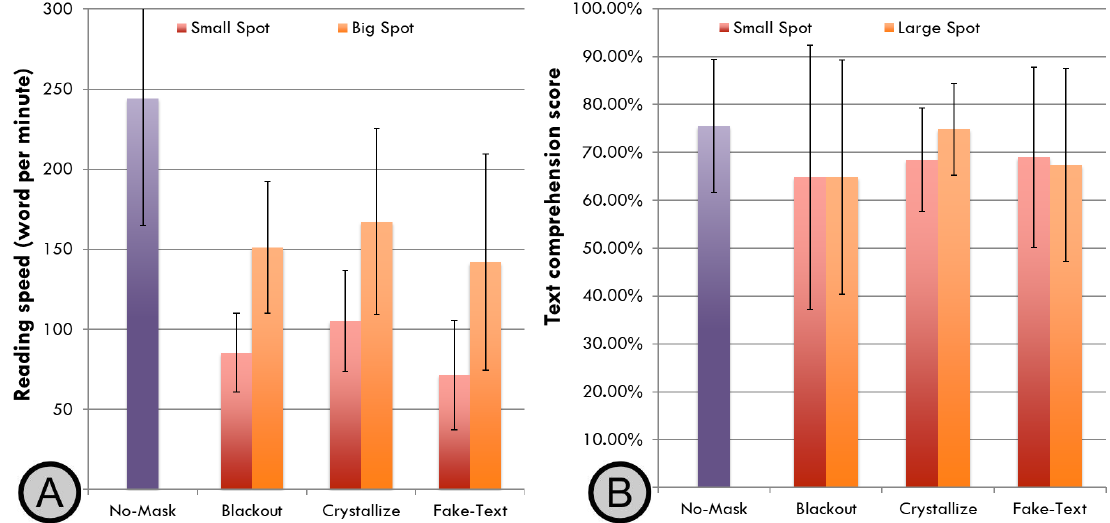
Figure 3. The masks resulted in slower reading speeds at the expense of reducing the amount of exposed content to shoulder surfers. While statistical testing only confirmed that no-mask resulted in a significantly faster reading speed, the figure suggests that reading was faster with larger spots and that users were faster when using the crystallized mask, followed by the blackout mask, and slowest when using fake text mask ( A ). As for comprehension, we could not find significant effects of masks and spot sizes on text comprehension. The differences were negligible, suggesting that EyeSpot does not have a strong impact on understanding the text ( B